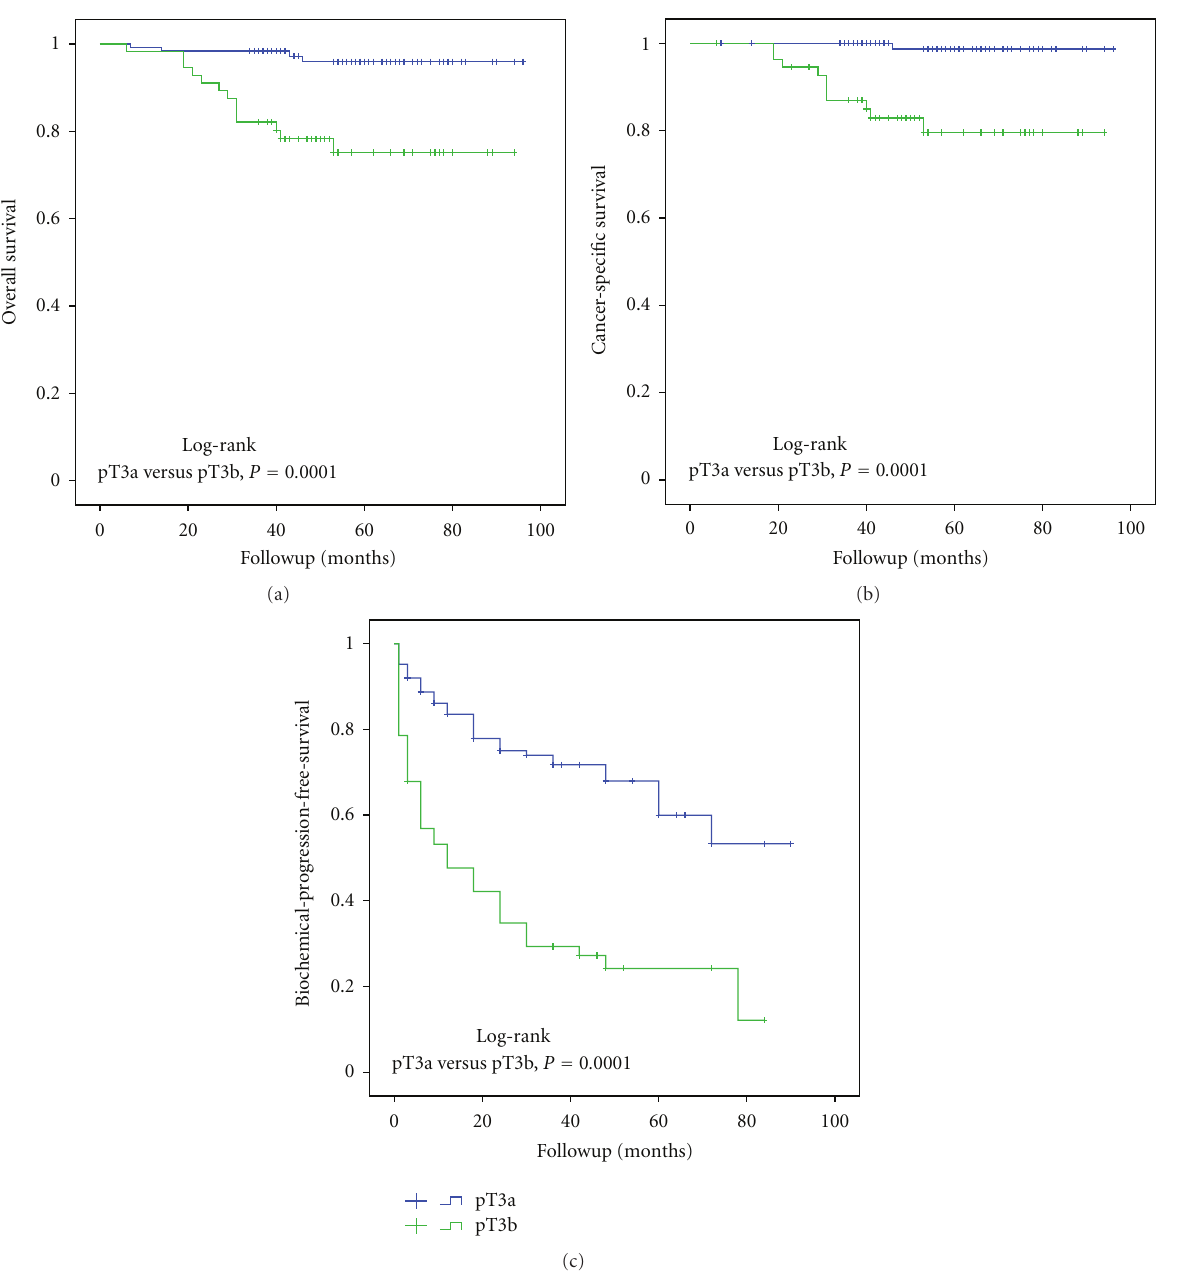
Figure 2: The Kaplan-Meier analysis with log-rank test for overall (a), cancer-specific survival (b), and biochemical-progression-free survival (c) stratified for pathological stage.